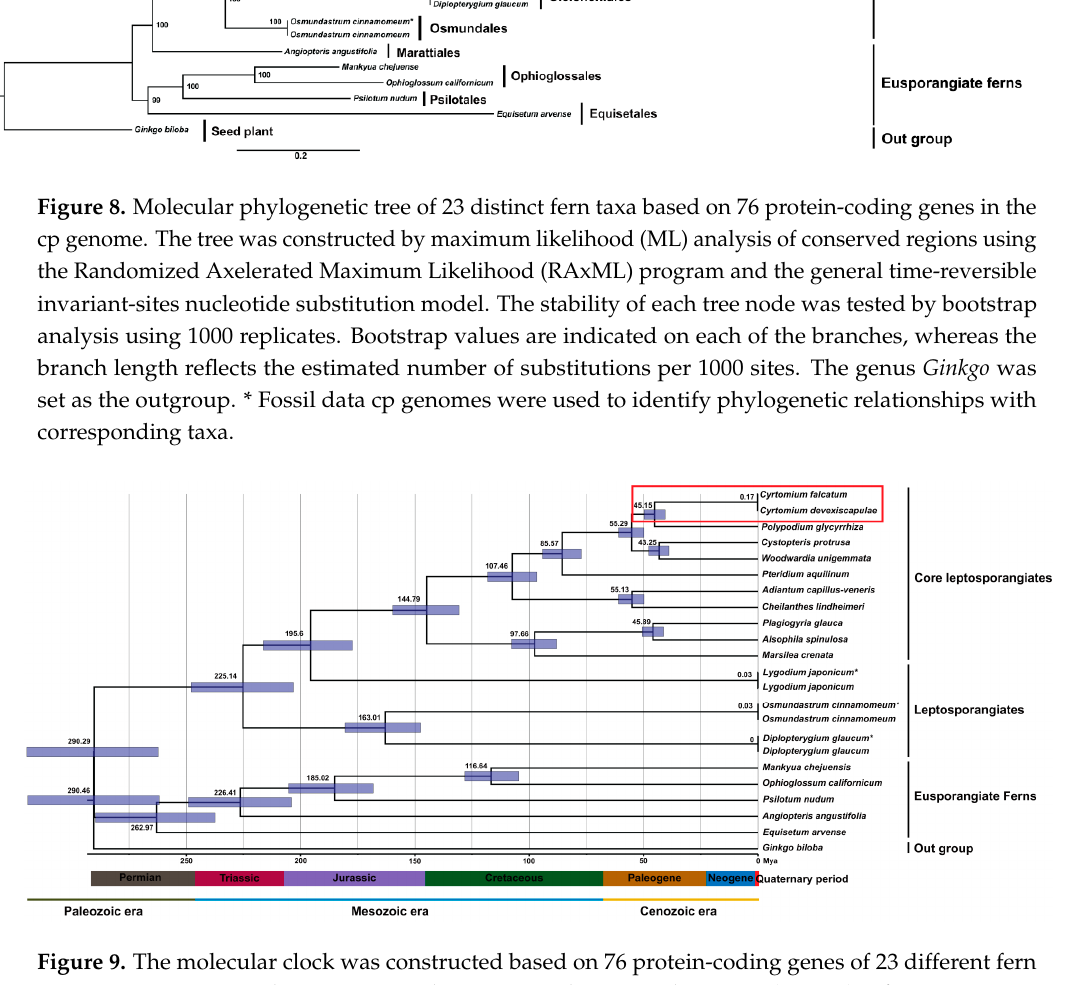
Figure 9. The molecular clock was constructed based on 76 protein ‐ coding genes of 23 different fern taxa cp genomes using the Bayesian Evolutionary Analysis Sampling Trees (BEAST) software program. Mean age estimates (in millions of years) are shown along the branches. The gray bars represent the 95% posterior density credibility interval for node ages. * Fossil data cp genomes were used to identify the molecular age of the corresponding taxa.